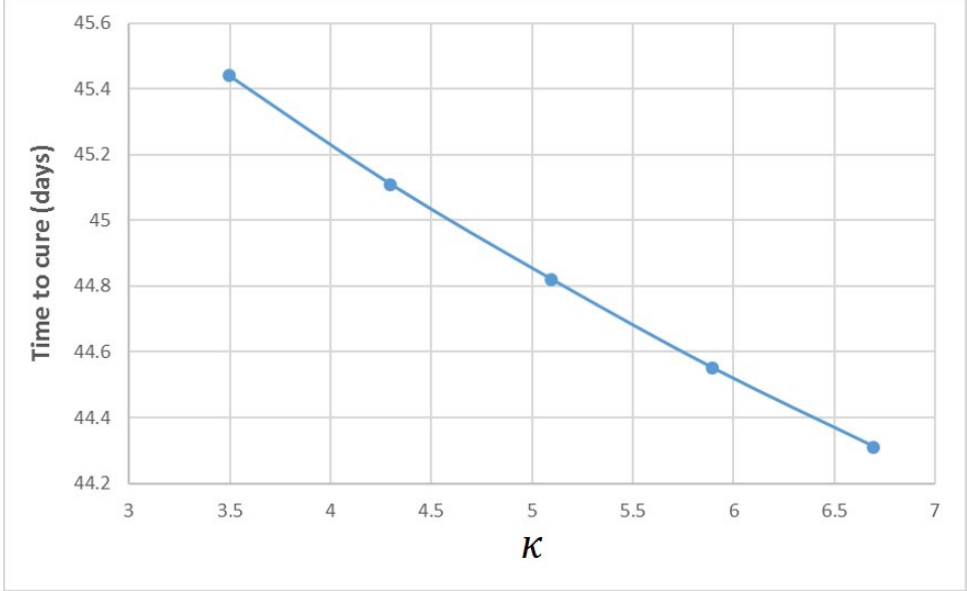
Figure A1. Influence of parameter κ in the multiscale model on time-to-cure.